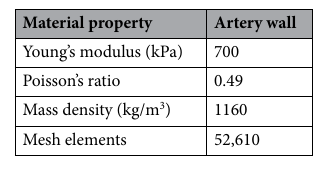
Table 1. Arterial Wall material